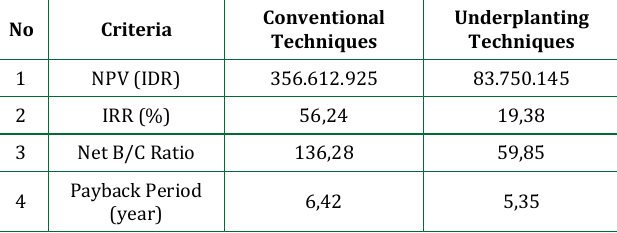
Table 5: The value of NPV, IRR, Net B/C Ratio, and payback period of conventional techniques and underplanting